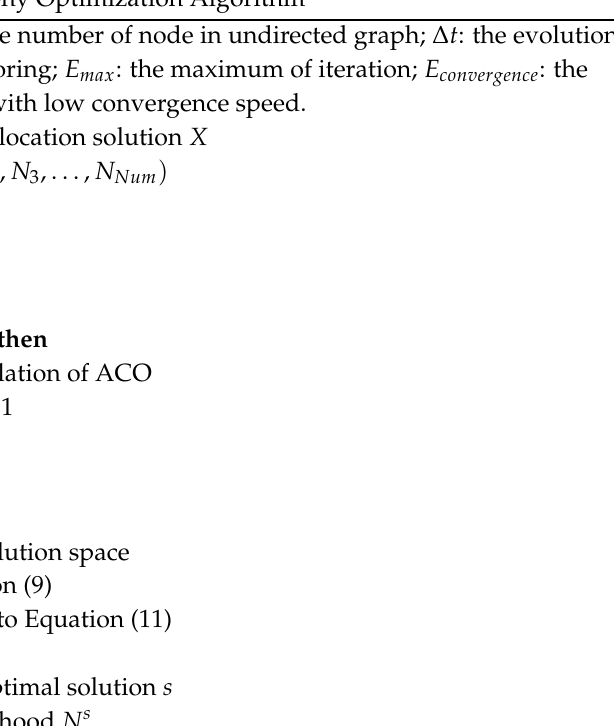
Algorithm 1: An Improved Ant Colony Optimization